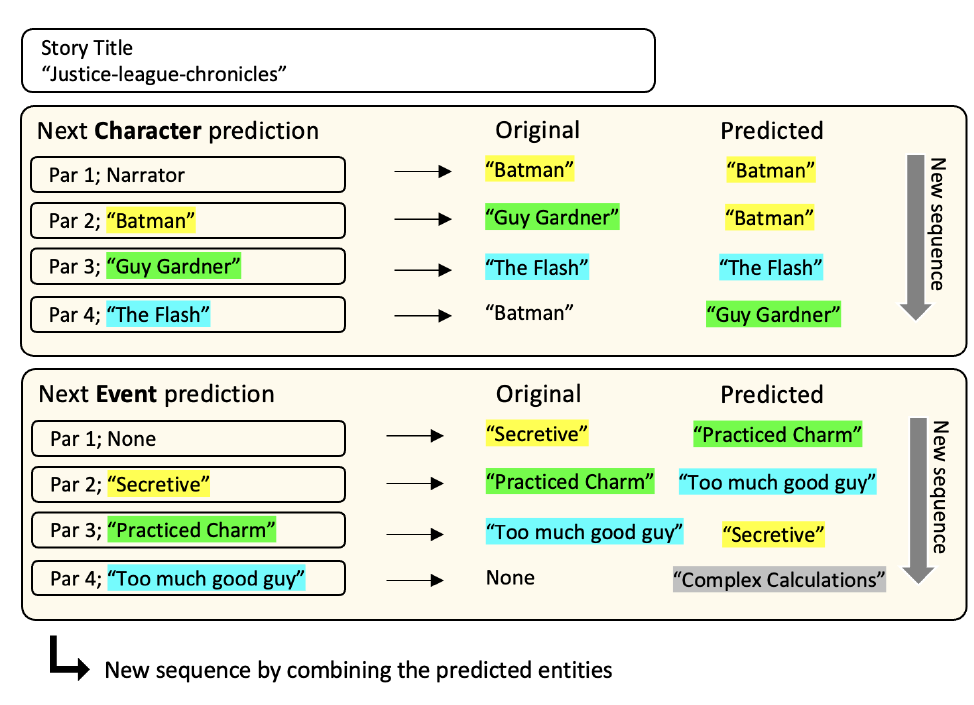
Figure 2. The example of predicted storyline entities by Storyline guidance